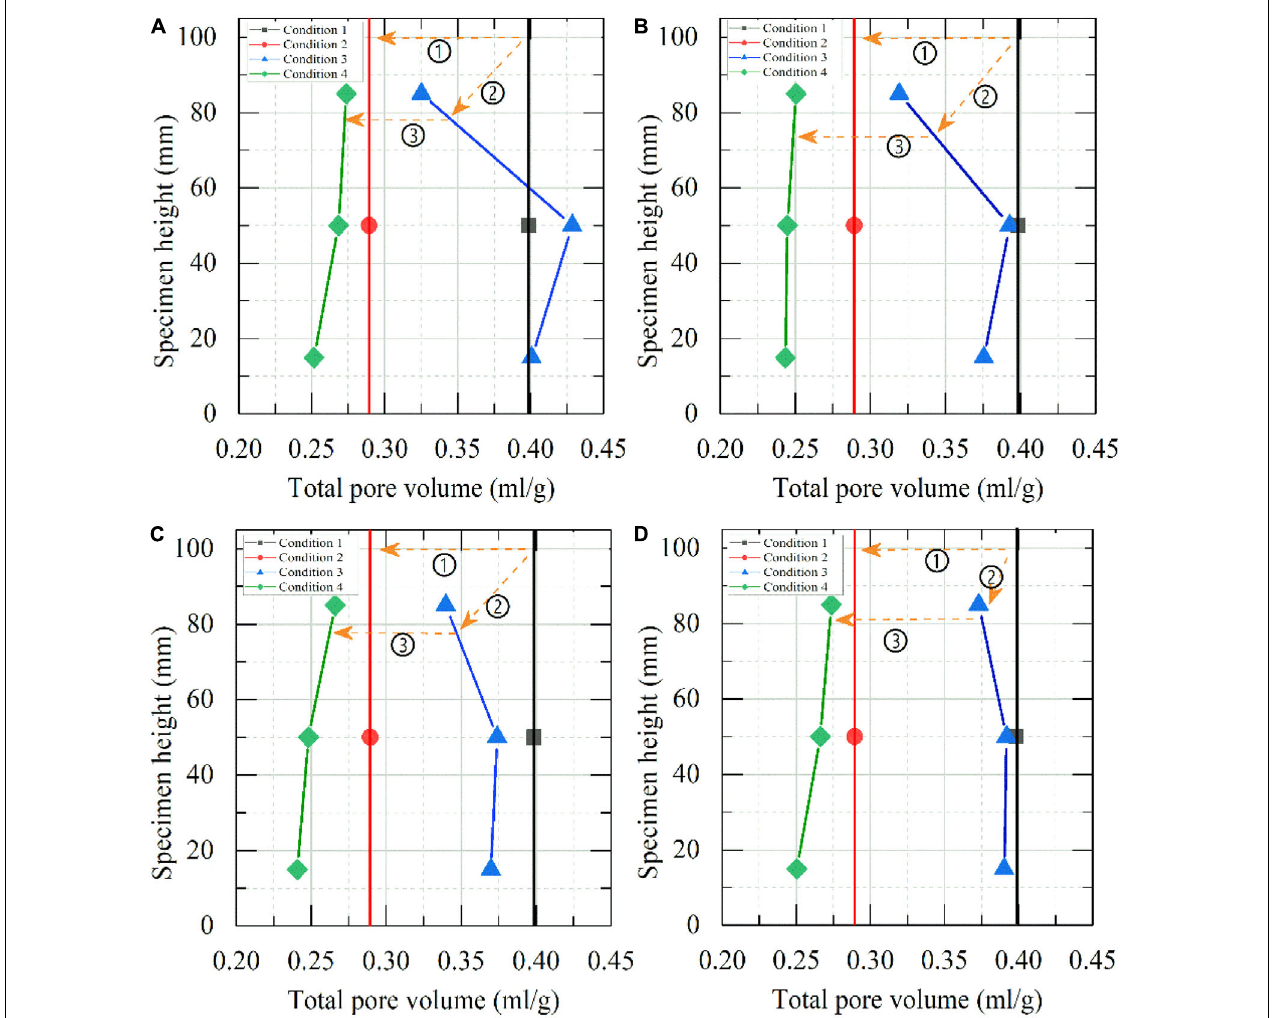
FIGURE 8 | Variation of total pore volume for soil samples with condition: (A) undisturbed, (B) after compressing, (C) after freezing-thawing, (D) after freezing-thawing and compressing. (cid:192) Consolidation test, (cid:193) freeze-thaw test, and (cid:194) consolidation test.